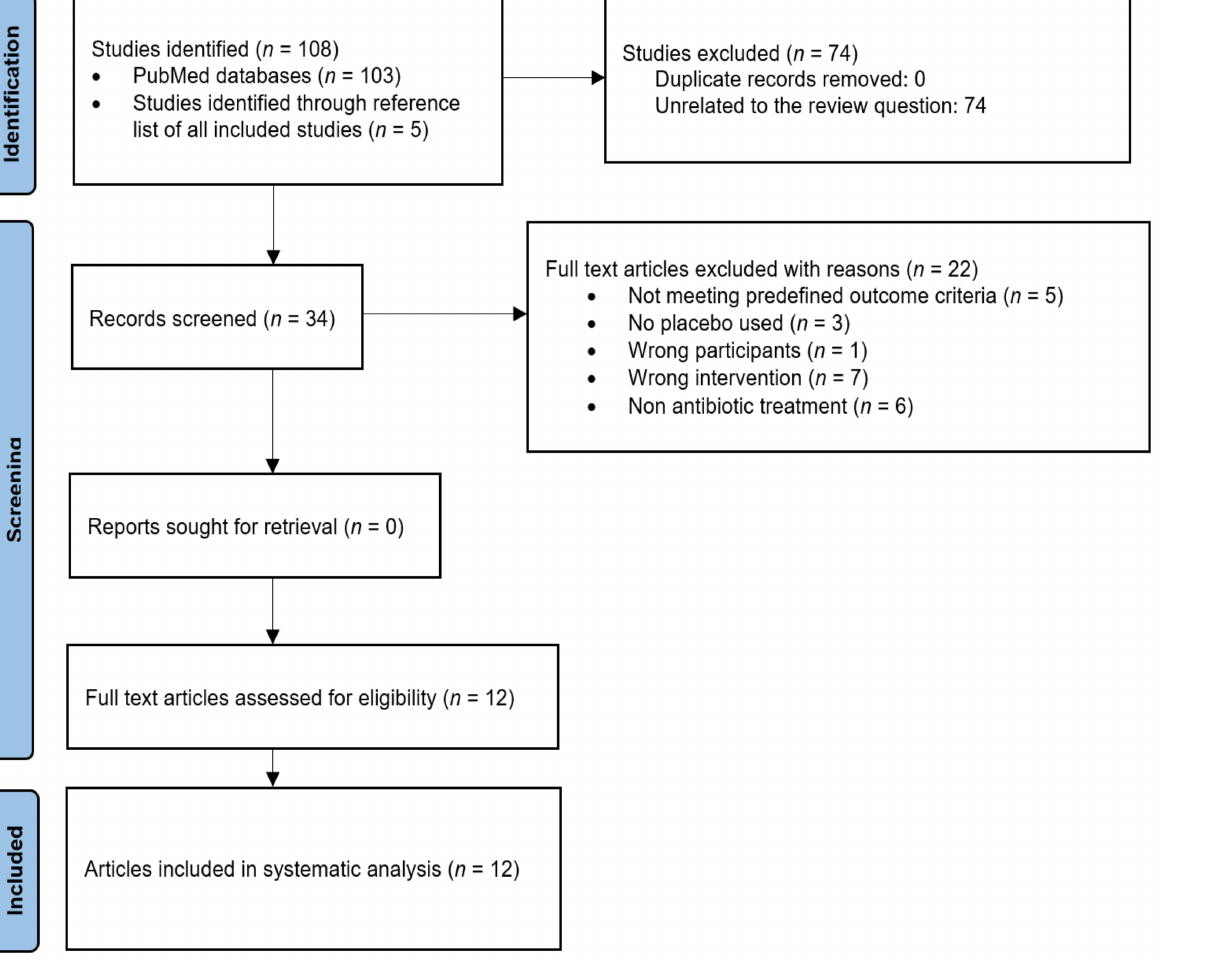
Figure 1. PRISMA flowchart showing the article selection